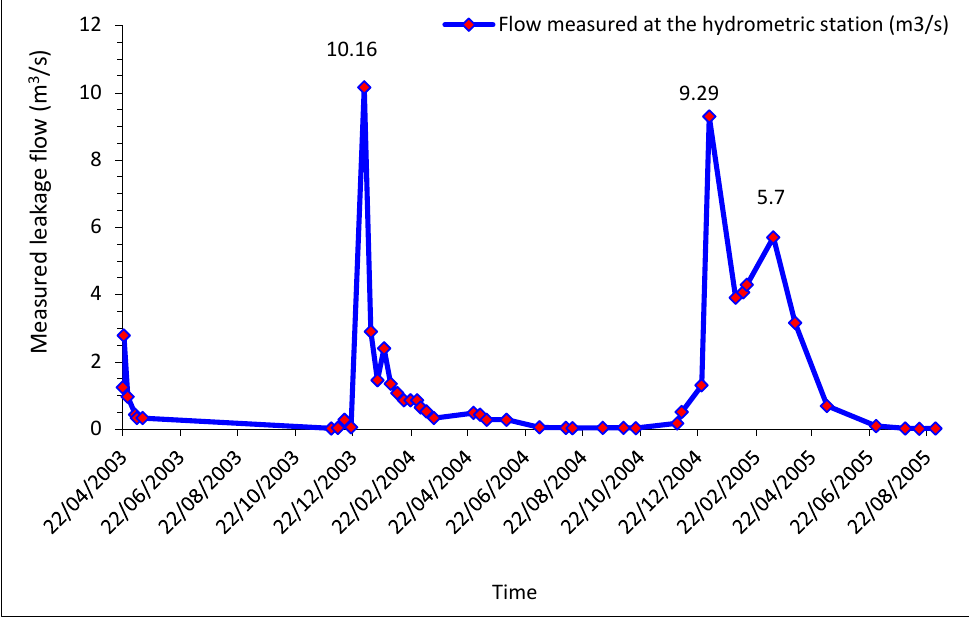
Figure 35. Variation over the time of the flow rate of water leaks measured downstream of Hammam Grouz dam This representation makes it possible to extract the maximum peak leakage values recorded on 23/04/2003, 14/02/2004 and 08/05/2005, which are successively of the order of 1.414, 1.279 and 1.14 m 3 /s.